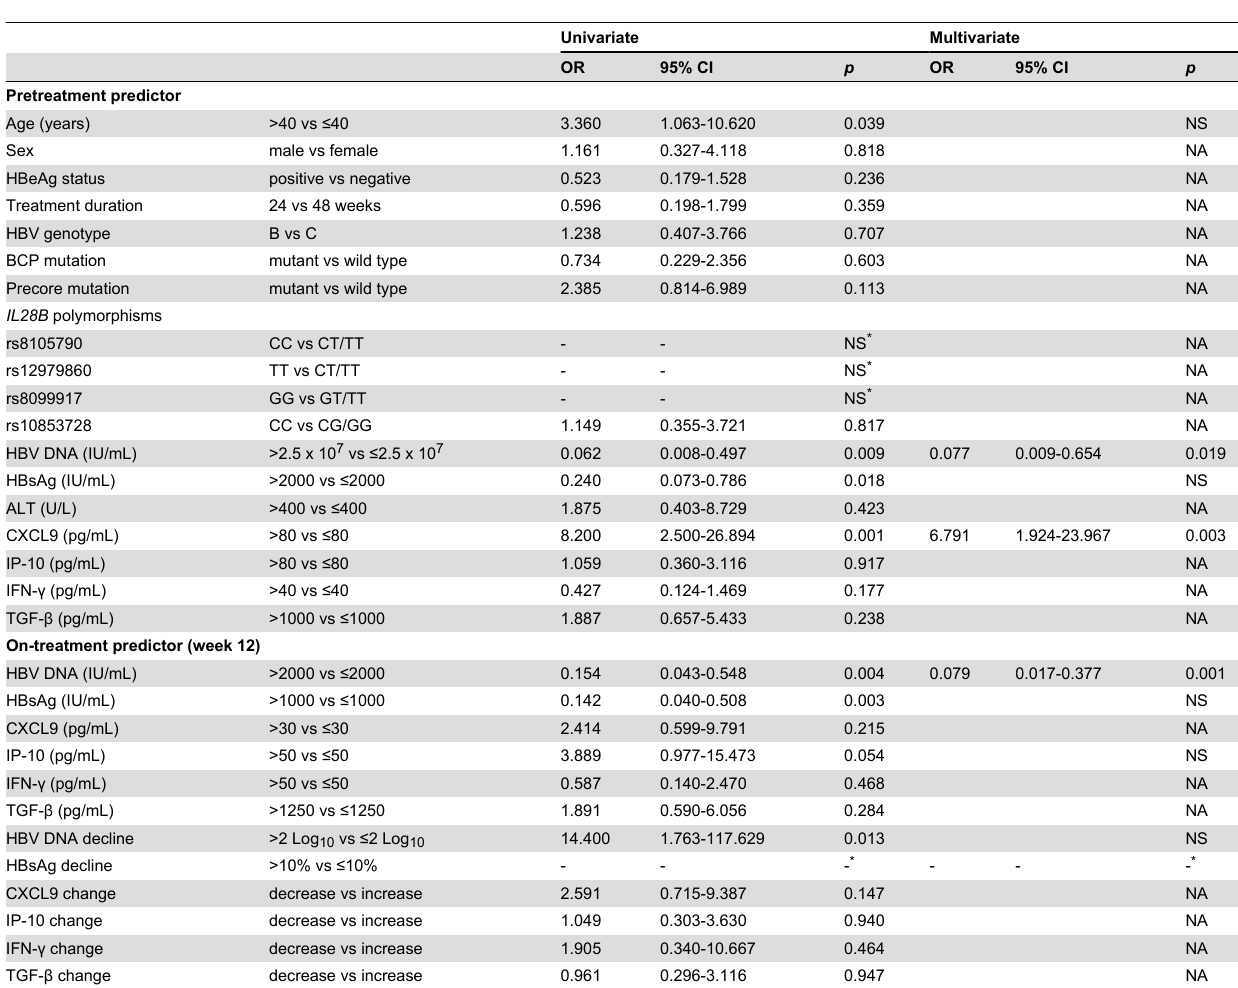
Table 3. Univariate and multivariate analyses of factors associated with sustained virological